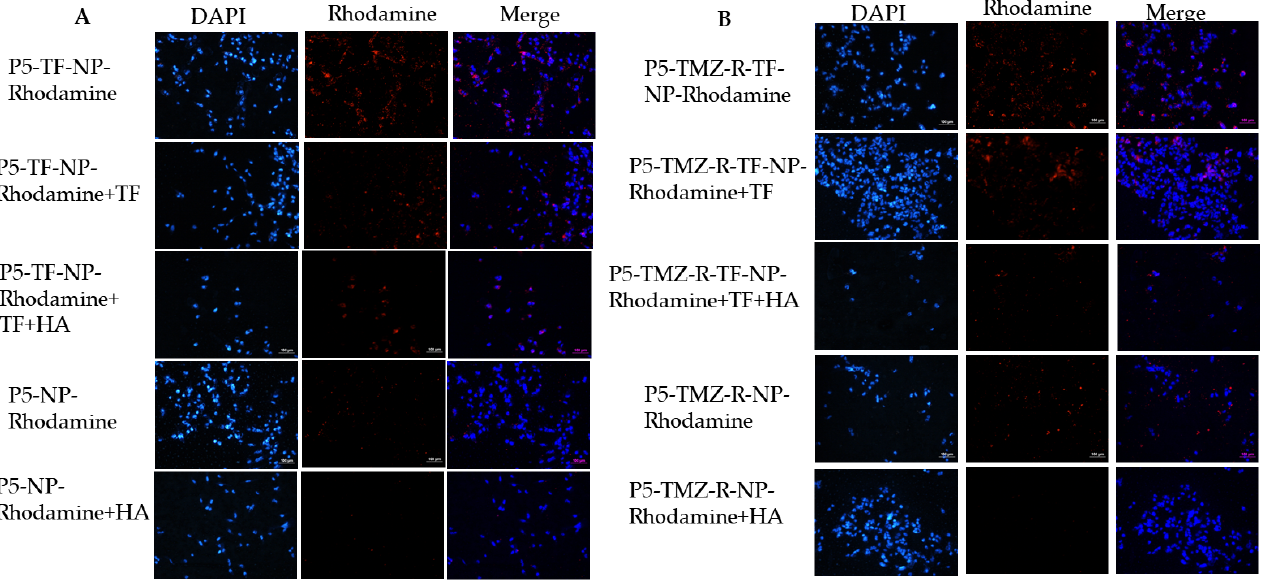
Figure 6. Cellular uptake of rhodamine B-encapsulated micelle and competitive inhibition assay using free transferrin, hyaluronic acid, or both using ( A ) P5 and ( B ) P5-TMZ-R cancer cells. Note: free transferrin and hyaluronic acid were incubated with the P5-and P5-TMZ-R brain cancer cells for the 1 h before treating with the rhodamine B-encapsulated micelle. The scale bar is 100 μ m.